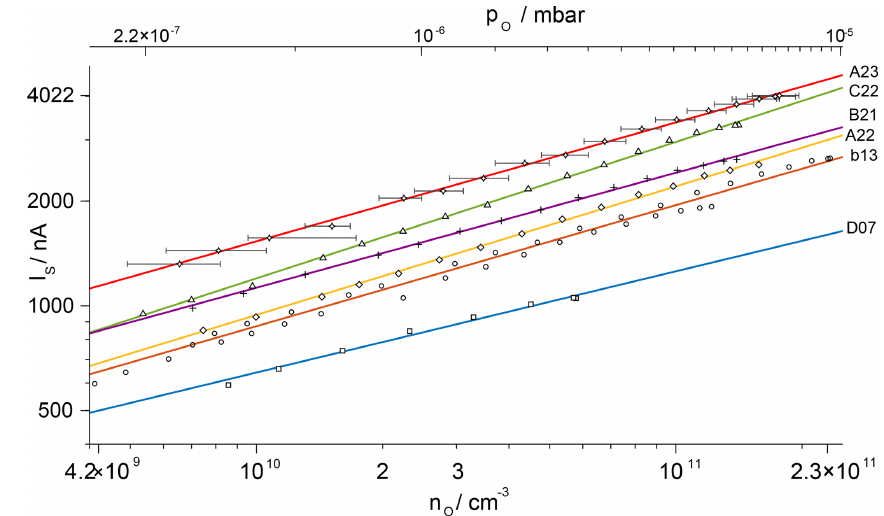
Figure 5. Calibration curves for atomic oxygen for sensors used on the WADIS-2 campaign in double-logarithmic plotting for a reference temperature of 293K. Solid lines represent power functions fitted to the measurement data. The uncertainty of the calibration is given exemplarily for sensor A23, with the standard deviation of I S below 10nA.